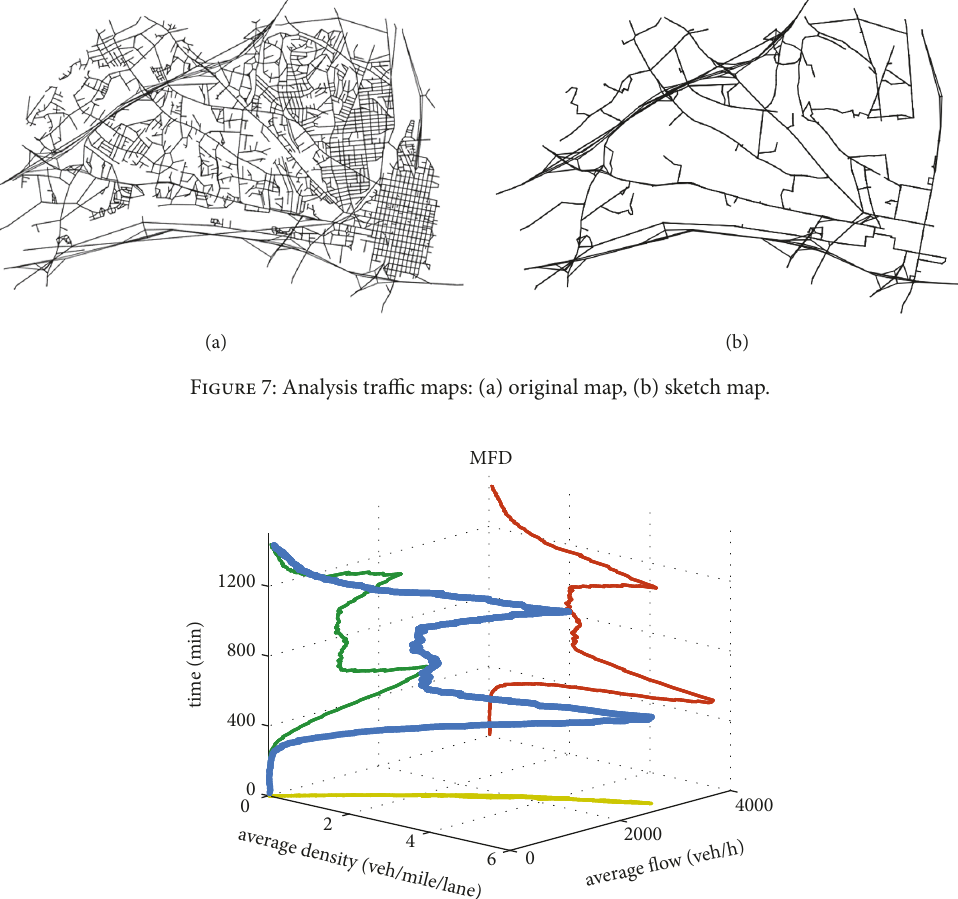
Figure 8: Network MFD (the projection in green is the time-dependent flow pattern, the projection in red is the time-dependent density pattern, and the projection in yellow is the relationship between flow and